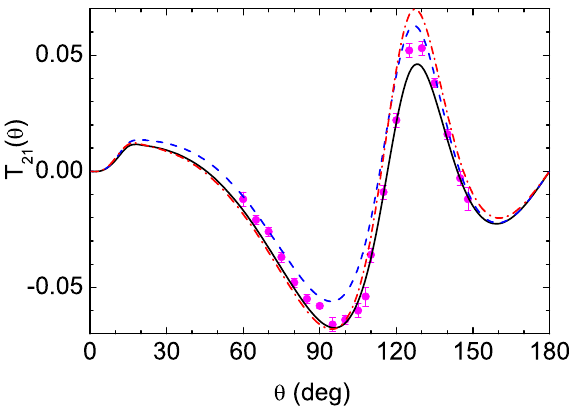
Fig. 5. Tensor analyzing power T 21 ( θ ) of the pd elastic scatter- ing at E p = 10.0 MeV (or equivalently E d = 20.0 MeV). The solid (black) curve denotes the calculation with AV18, the dashed (blue) curve that with AV18 + BR 680 , and the dashed-dotted (red) curve one with AV18 + BR 800 + V πσ . Experimental data are taken from Ref. [10].